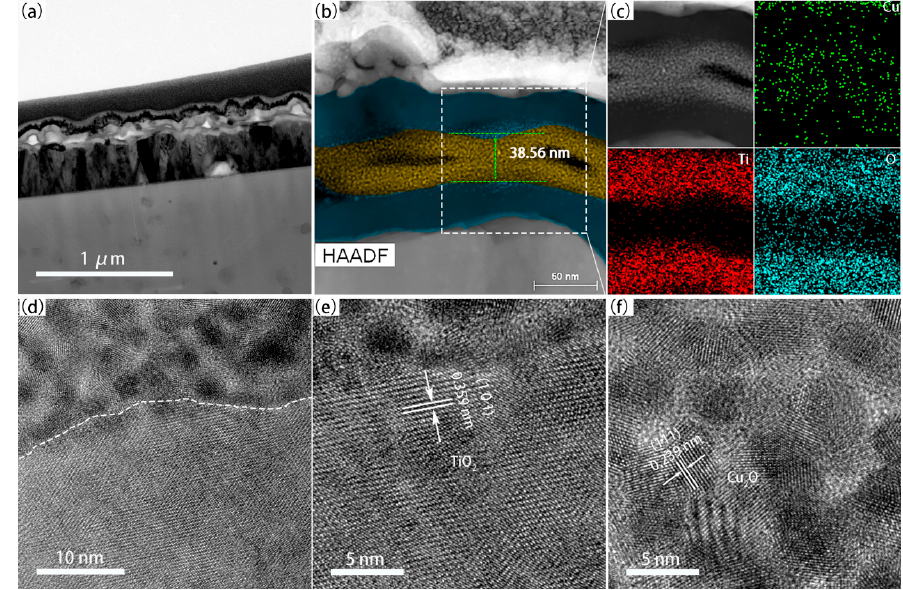
Figure 3. Cross-sectional TEM image with low magnification (( a ) 1 μ m and ( b ) 50 nm); EDX image ( c ); and high resolution TEM images at the interface ( d ) between TiO 2 layer ( e ) and Cu layer ( f ) of